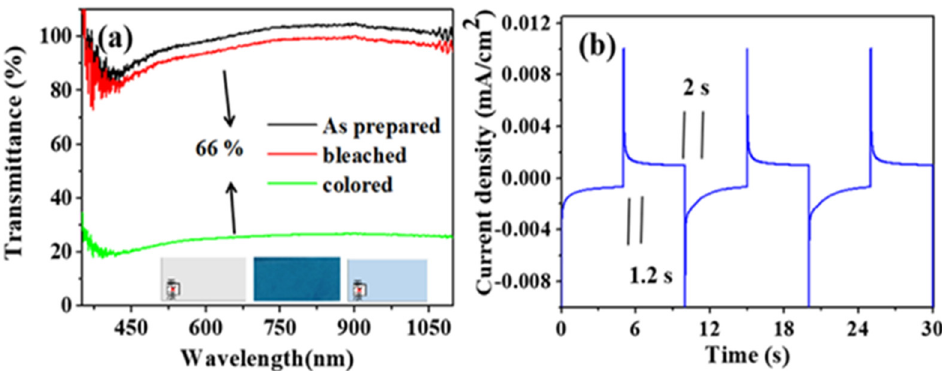
Figure 6. Cyclic voltammograms of WO 3 nanowires electrodes at a scanning rate of 10 mV/s ( a ) in the potential range of − 2 to +2 V and the optical transmittance spectra of WO 3 nanowires in the colored and bleached states. The inset images are photographs of the as − prepared WO 3 and the WO 3 nanowires film in the colored and bleached states. ( b ) The chronoamperometric curve of the WO 3 nanowires film.